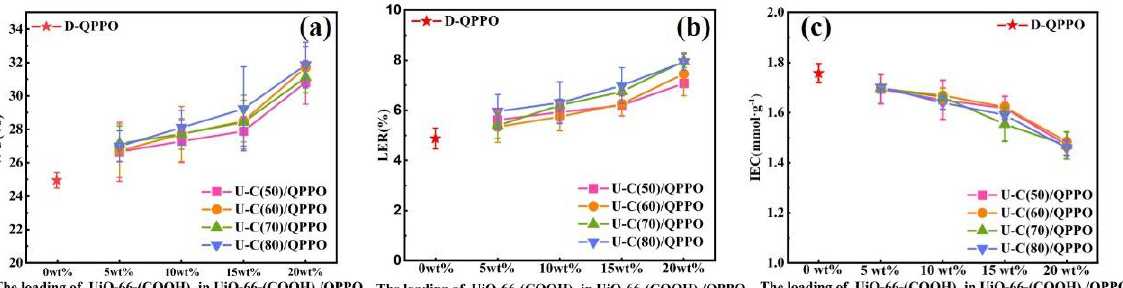
Figure 3. ( a ) WU, ( b ) LER, and ( c ) IEC of UiO-66-(COOH) 2 /QPPO membranes with four kinds of MOF of different carboxyl group contents under different MOF fillers.